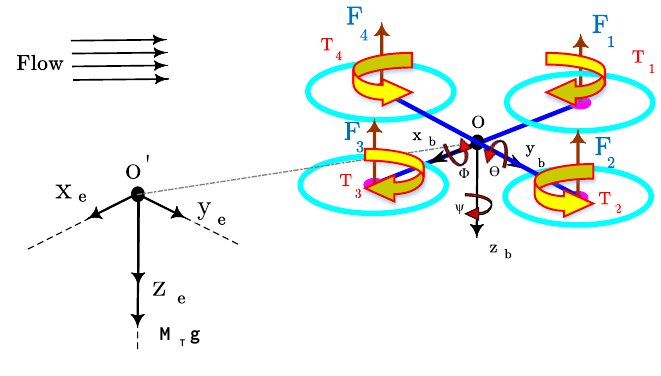
Figure 1. Reference frames of the unmanned aerial vehicle